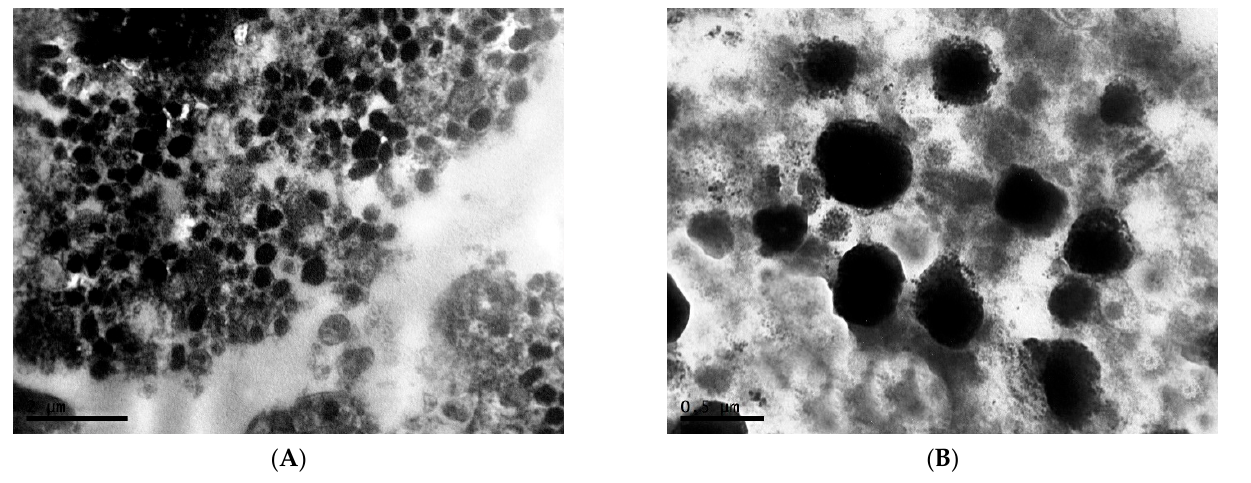
Figure 9. Characteristics of melanosomes of cells of transplantable malignant melanoma B16 under the influence of constant lighting. TEM, ( А )—×14,000, ( B )—×20,000. A characteristic feature of the cells of this group is the content of a large number of melanosome complexes in them. There is a presence of spherical formations of various sizes, surrounded by a membrane, which contain a large number of melanosomes of varying degrees of maturity (Figure 10A–C).